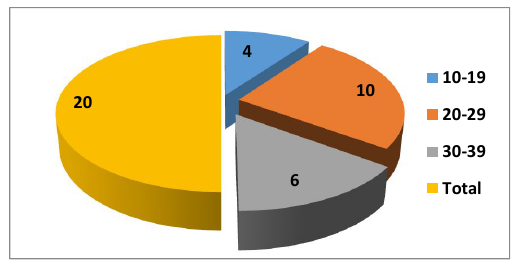
Figure 3: Age distribution in relation to decades.